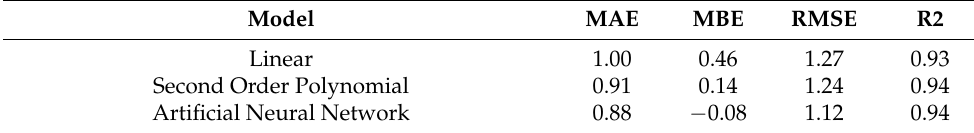
Table 6. Statistical performance of UAS FDPR thermal calibration